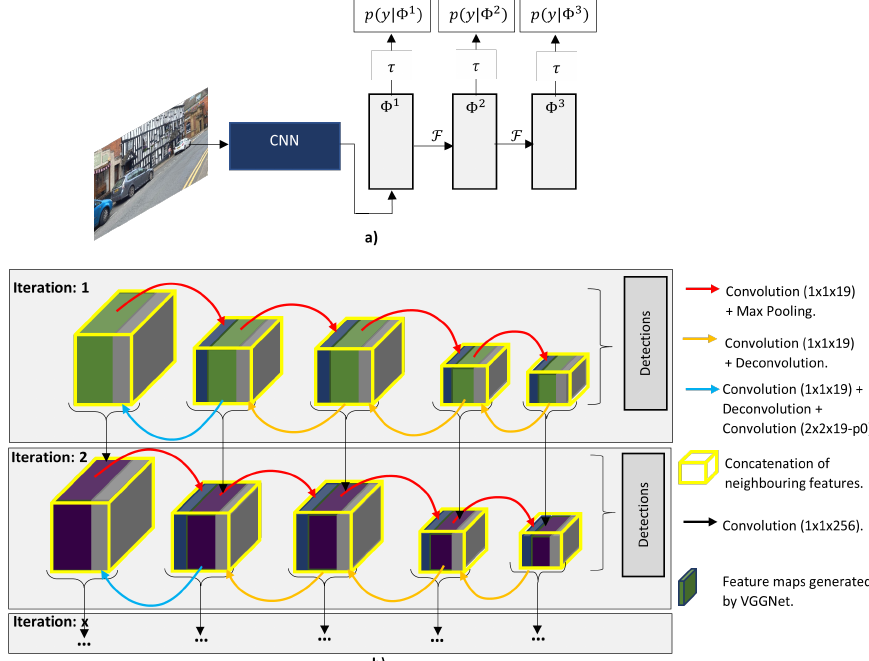
Figure 14. Recurrent Rolling Convolution (RRC): ( a ) The recurrent component of the RRC, where I is the input image, Φ is the feature map and F is feature aggregation function. This block is considered recurrent because the weights for F and τ are shared in each step, for instance from Φ 1 to Φ 2 and to Φ 3. ( b ) It is considered the rolling component because it performs downwards and upwards feature aggregation